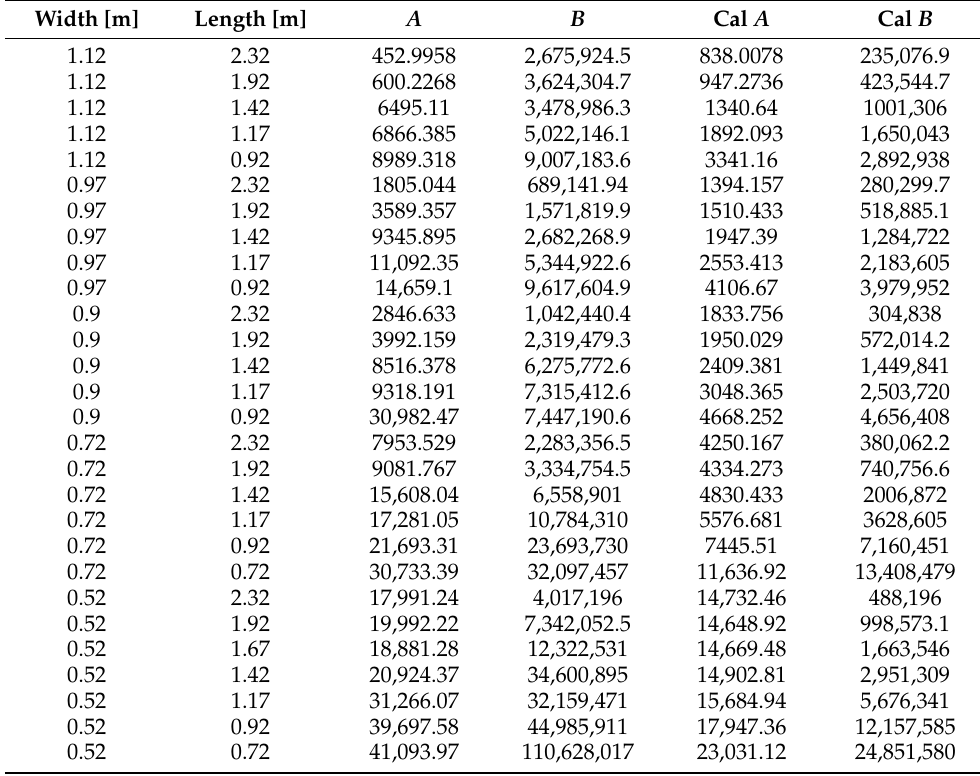
Table A4. The 6 mm plate Polygal vacuum tests A , B and theory calculated A , B .